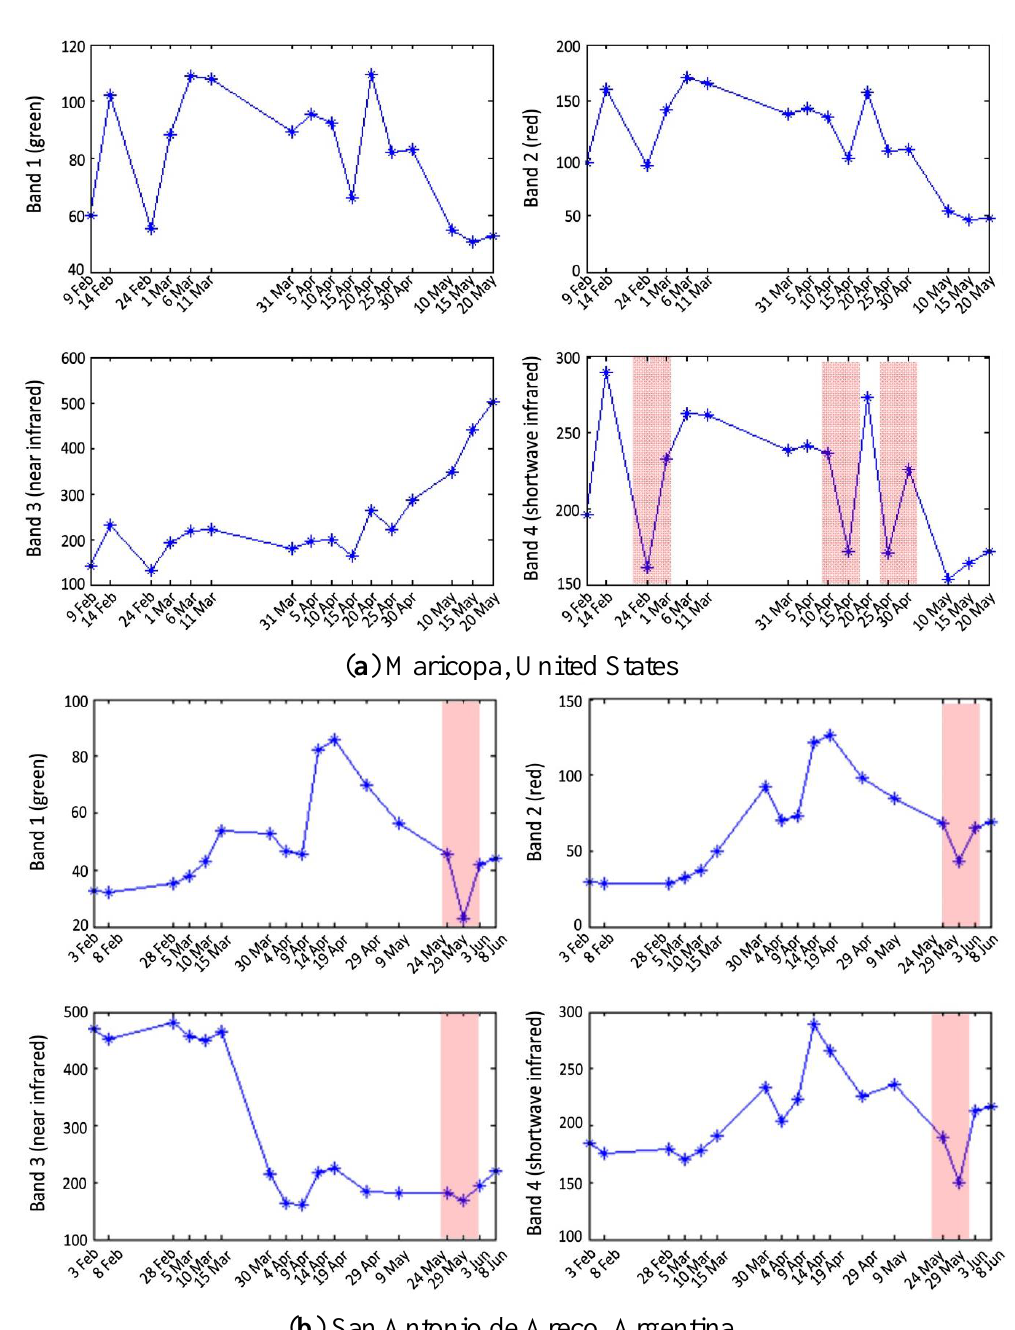
Figure 6. Temporal profiles in the four spectral bands of the SPOT4 (Take 5) time series over the ( a ) American and ( b ) Argentinian sites. Irrigation periods are highlighted in red. Finally, the temporal consistency of the reflectance values between sensors (SPOT4 (Take 5) and Landsat 8) was evaluated, for the sites of France, Morocco and Belgium. Landsat 8 data were resampled to 20 meters and the same methodology as before was applied, thus analyzing temporal profiles made of two sensors. The conclusion was that the profiles coming from the two sensors were coherent and temporally consistent, as shown in Figure 7 for the Moroccan